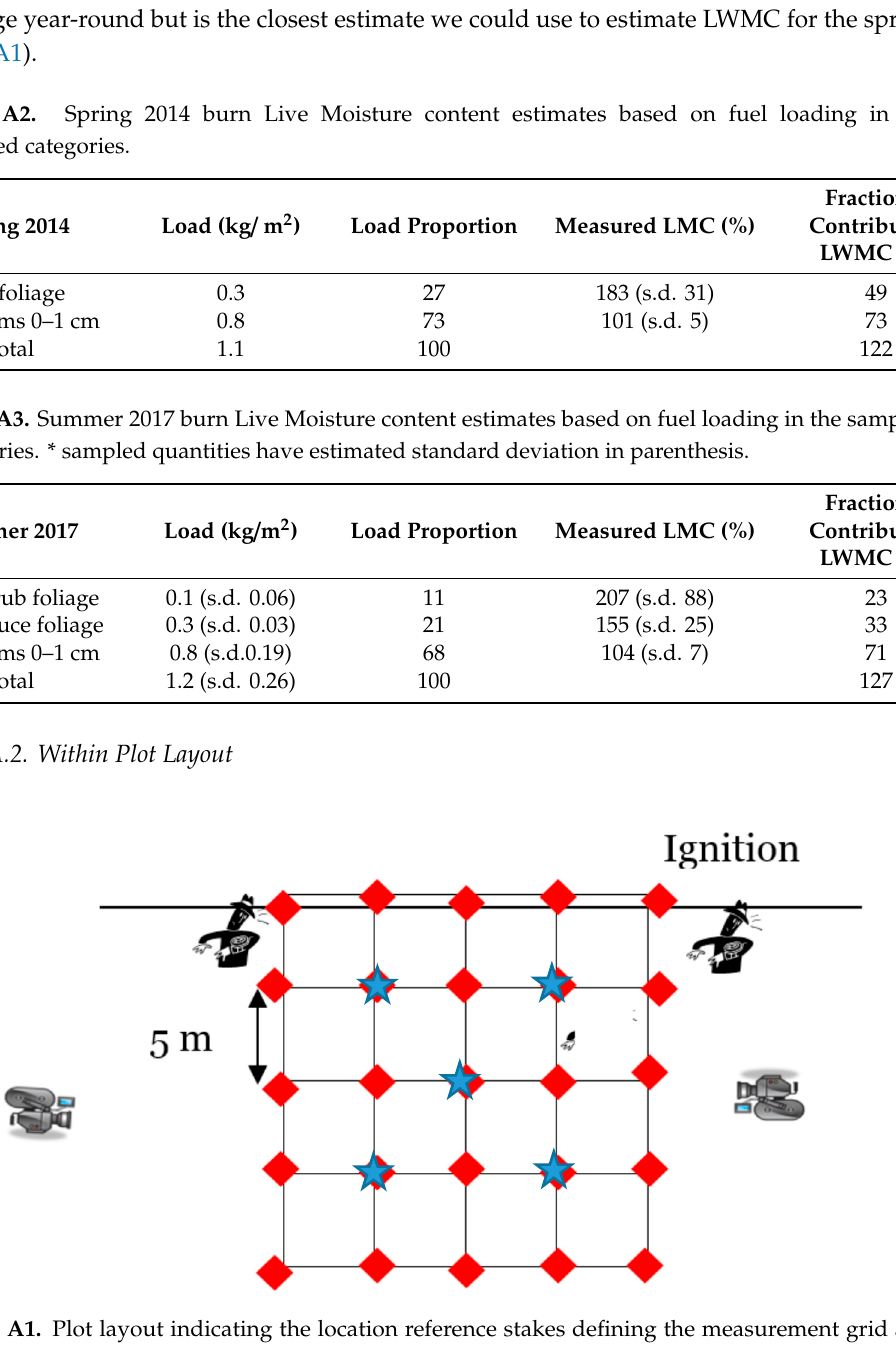
Figure A1. Plot layout indicating the location reference stakes defining the measurement grid and thermocouples layout (stars show thermocouple positions). Table A4. Fuel consumption for Paquette Lake Summer 2017 burn units (n=5/burn unit).